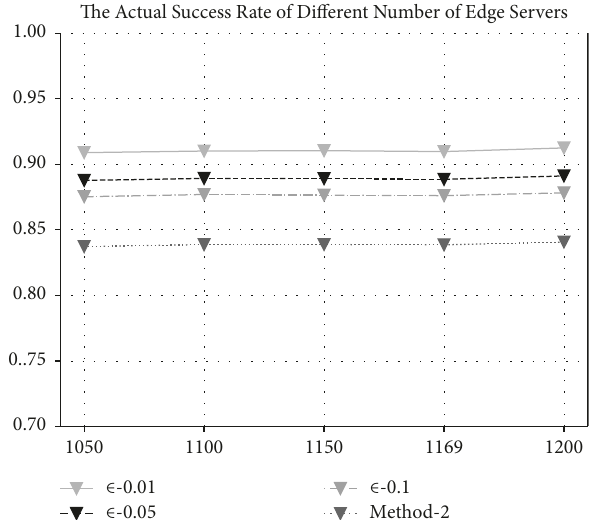
Figure 11: The actual success rate of different numbers of edge